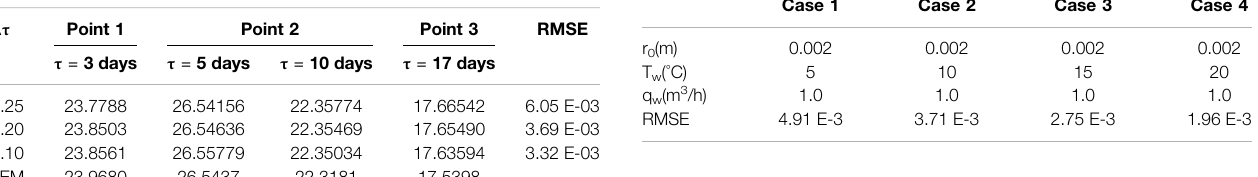
TABLE 2 | Comparison of numerical and re fi ne solutions under different time increment conditions, for Example two.